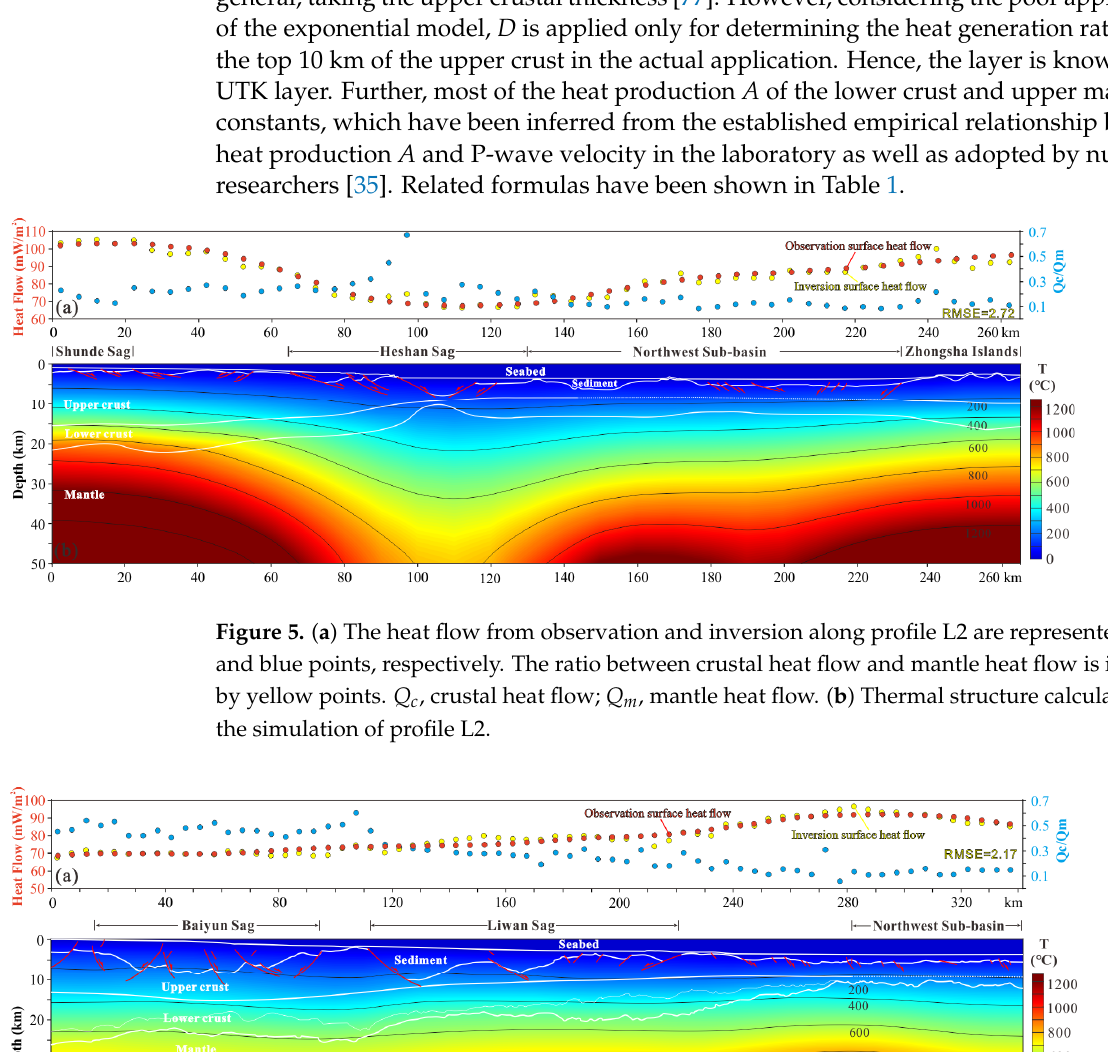
Figure 5. ( a ) The heat flow from observation and inversion along profile L2 are represented by red and blue points, respectively. The ratio between crustal heat flow and mantle heat flow is indicated by yellow points. Q c , crustal heat flow; Q m , mantle heat flow. ( b ) Thermal structure calculated from the simulation of profile L2.